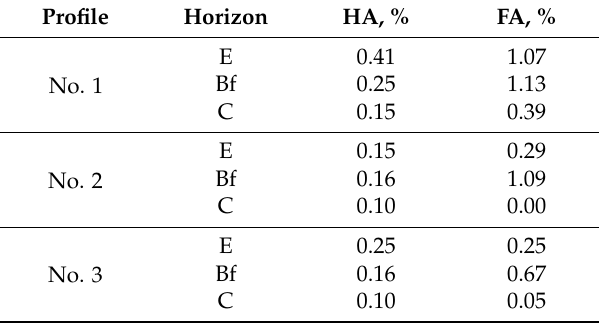
Table 8. Concentration of humic acid (HA) and fluvic acid (FA) carbon in surface sediments at Novye Peski.